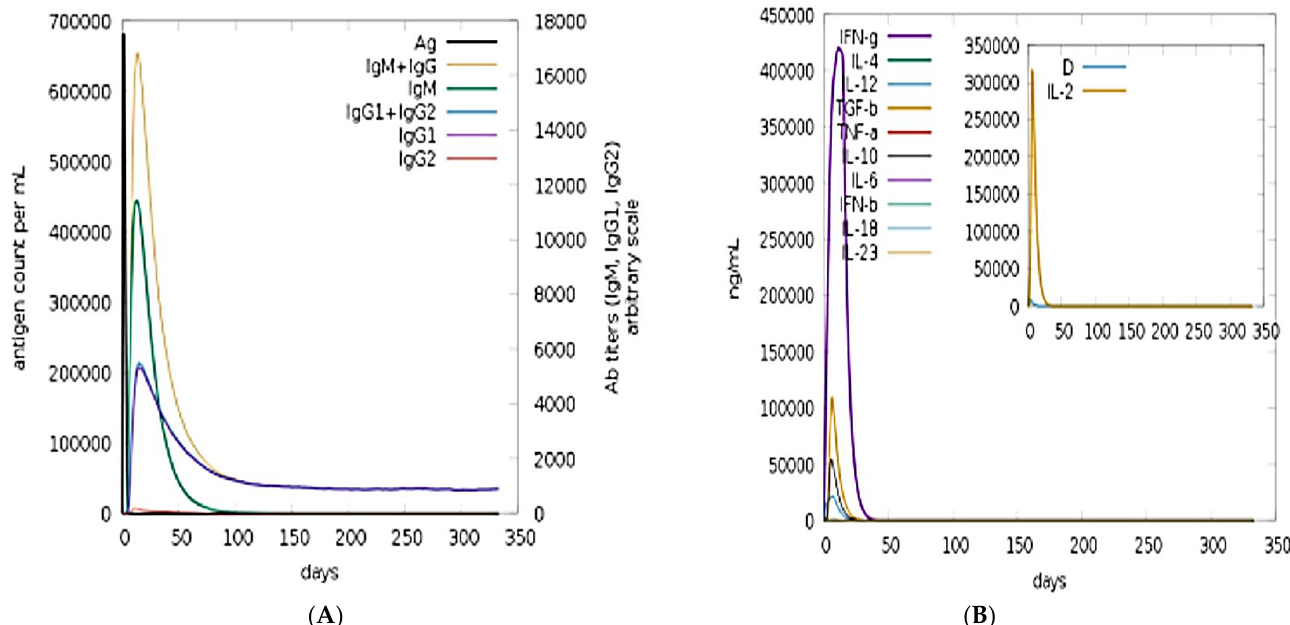
Figure 8. Immune simulations in response to the vaccine antigen: ( A ) antibodies count and ( B ) interleukins and cytokines counts in response to the